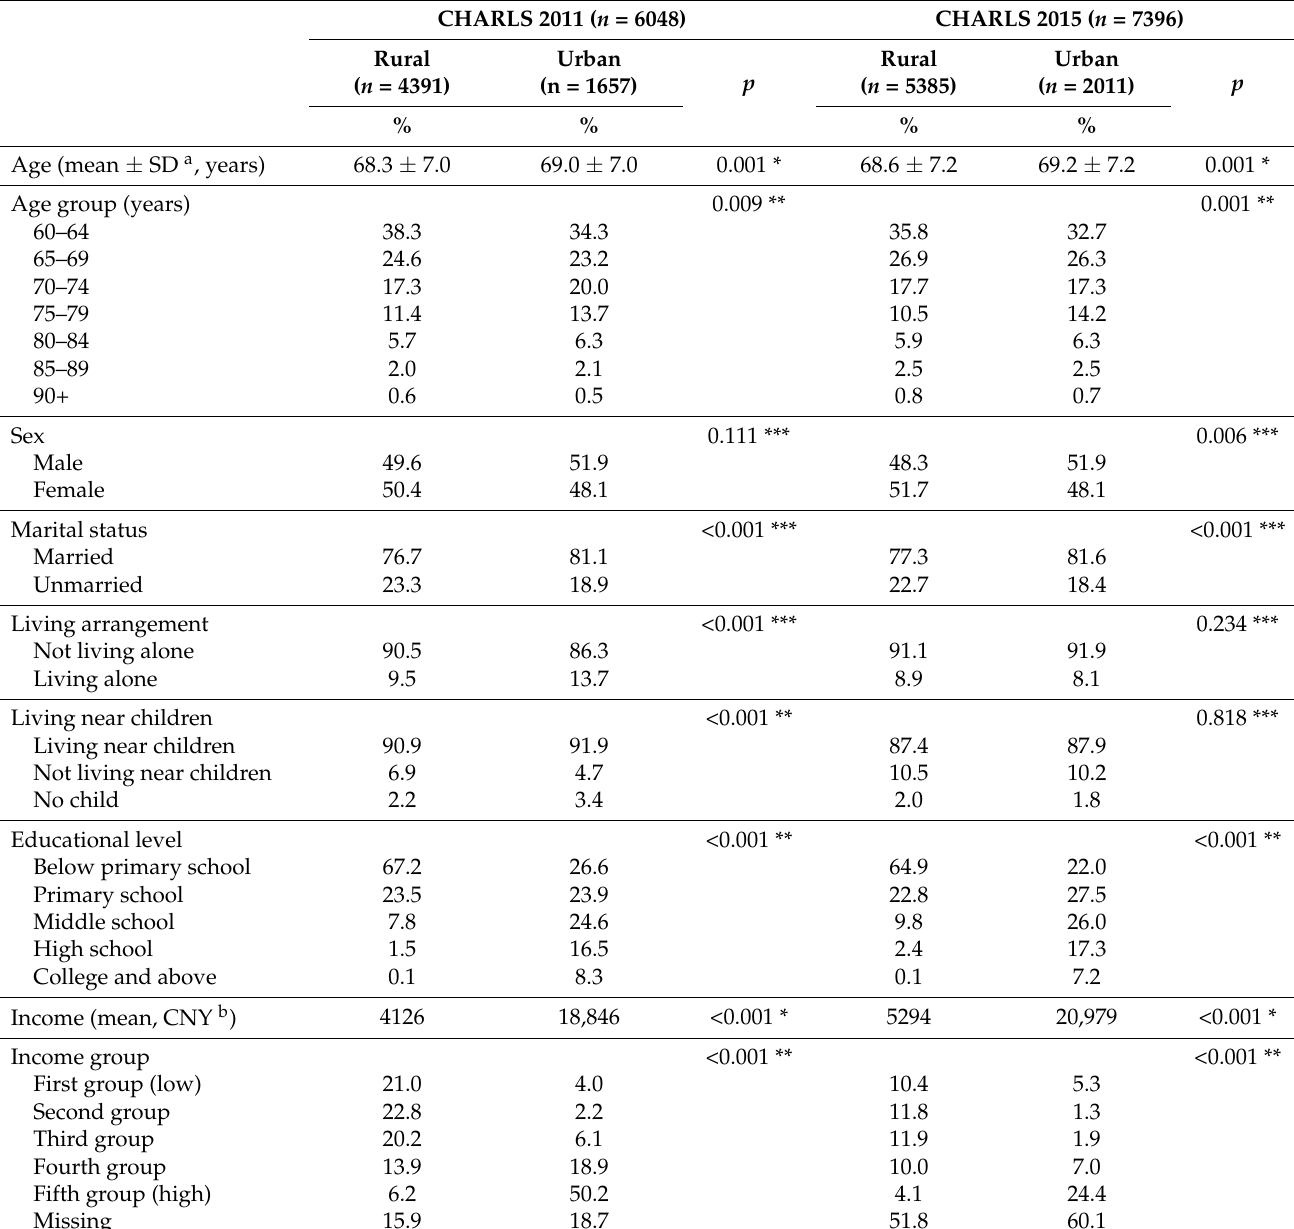
Table 3. Characteristics of rural and urban respondents, CHARLS 2011 and CHARLS